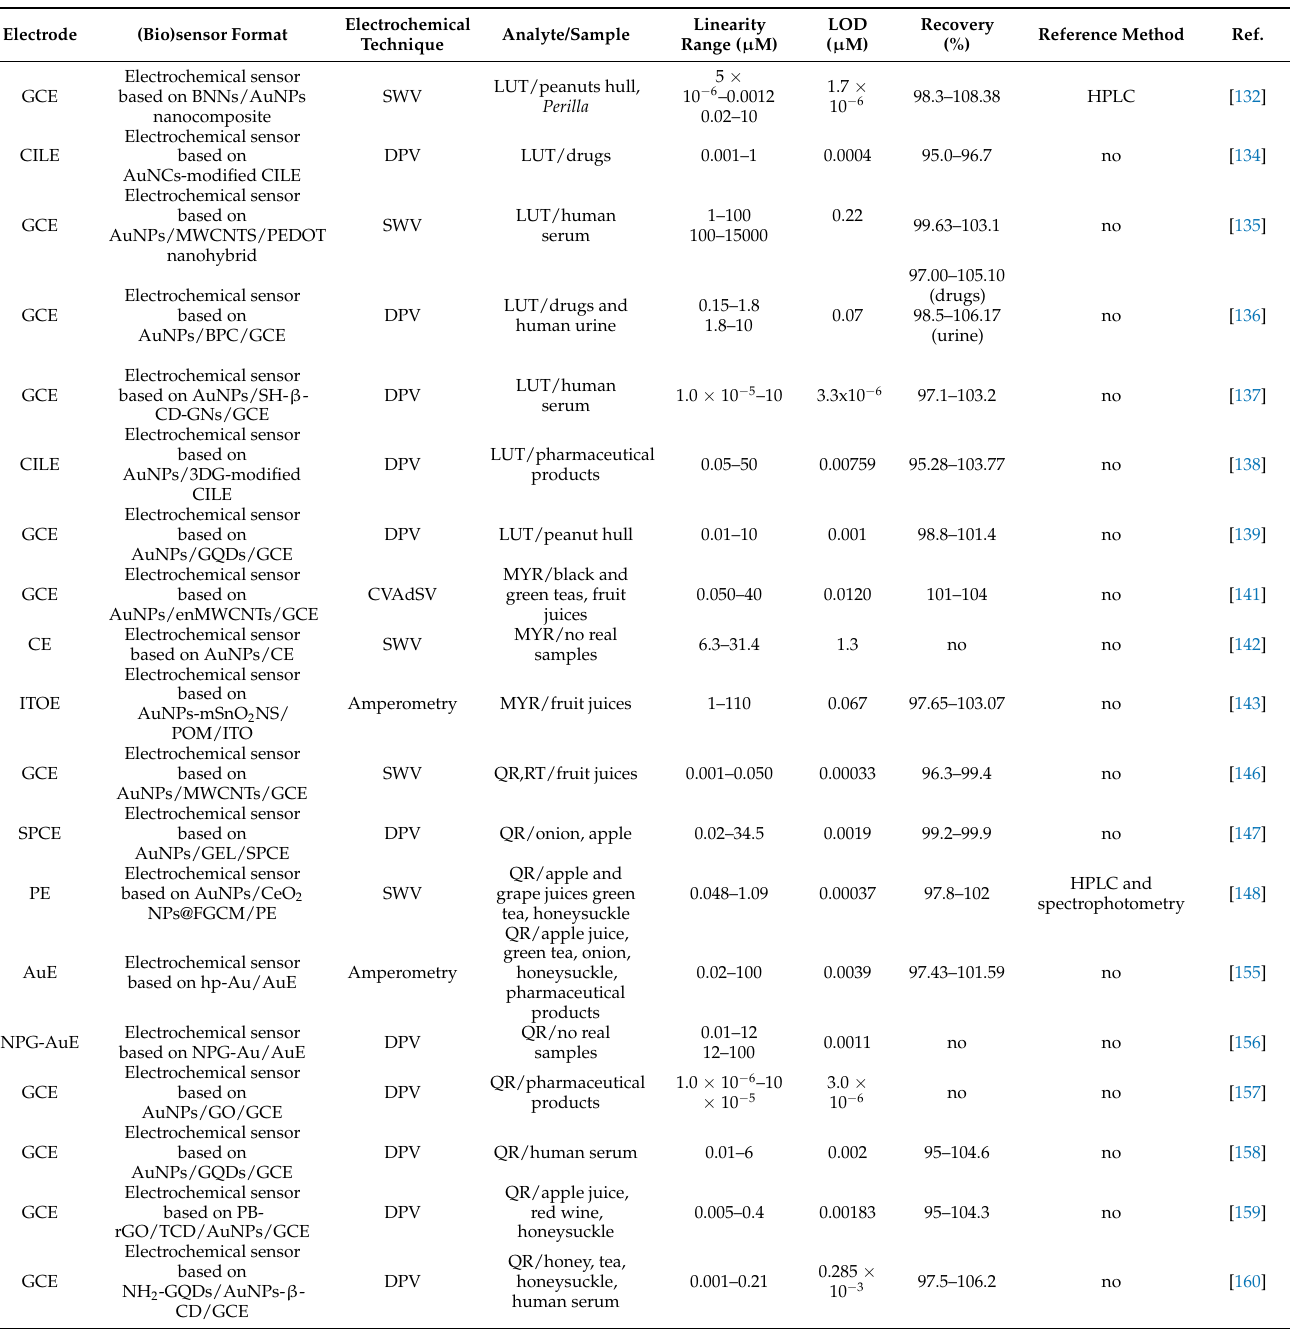
Table 3. Performances of electrochemical sensors for flavonoid